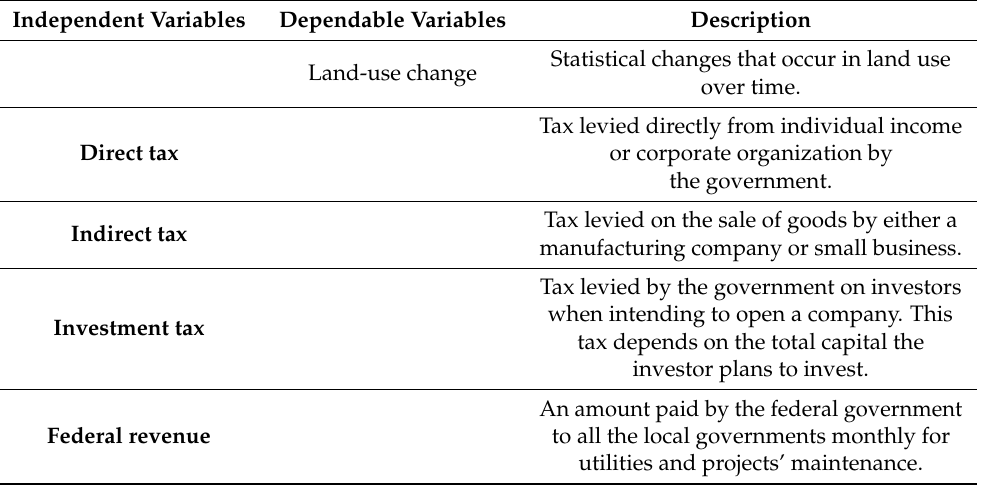
Table 1. Description of the